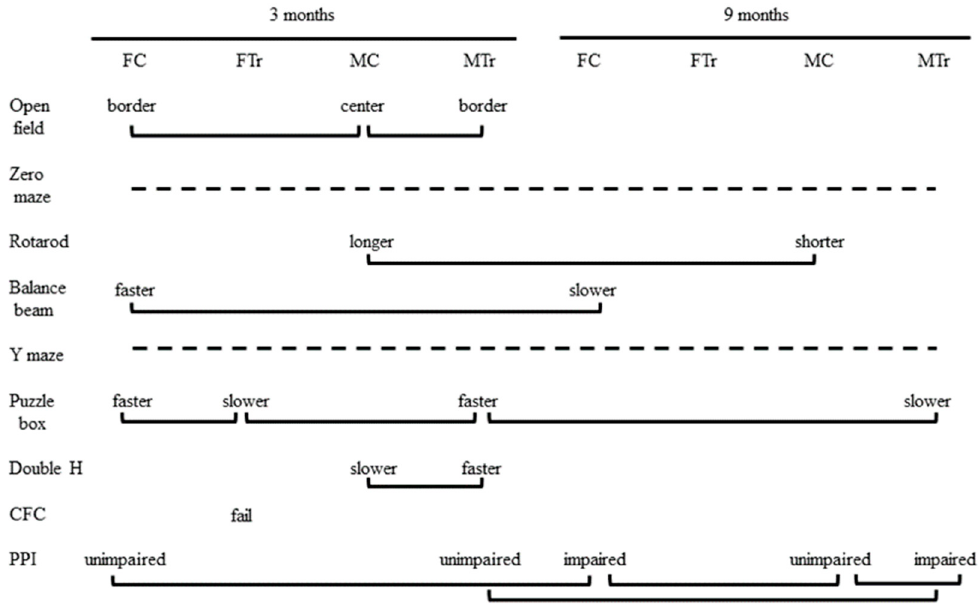
Figure 8. Summary of sex, genotype, and age differences for all tasks. Solid lines indicate comparisons with significant differences between groups. Dashed lines indicate tasks showing no differences between any groups. PPI, prepulse inhibition of acoustic startle. CFC, context fear conditioning.